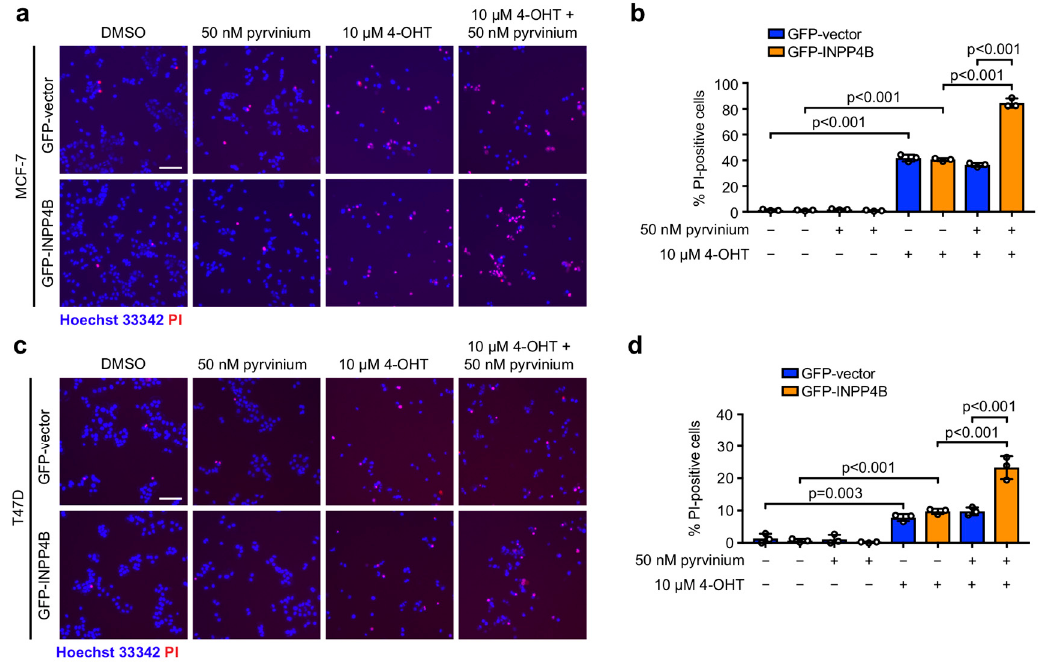
Figure 4. 4 ‐ OHT ‐ pyrvinium treatment selectively enhances INPP4B ‐ overexpressing ER + breast cancer cell death. ( a – d ) MCF ‐ 7 ( a , b ) or T47D ( c , d ) cells expressing GFP ‐ vector or GFP ‐ INPP4B were treated with 50 nM pyrvinium and/or 10 μ M 4 ‐ OHT or DMSO as a vehicle control for 48 h , then incubated with 1 μ g/mL propidium iodide (PI) and 1 μ g/mL Hoechst 33,342 for 30 min ( a , c ). Data represent the percentage of PI ‐ positive cells ± SD ( n = 3 experiments, >300 cells/experiment) ( b , d ). Scale bar is 100 μ m in a , c . + indicates where treatment was added, and – indicates where no treatment was added. p values were determined by one ‐ way ANOVA with Tukey post hoc test in ( b , d ).